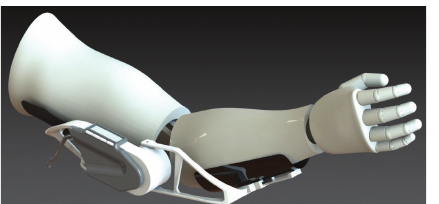
Figure 11: One possible design for the future version of the active orthosis.